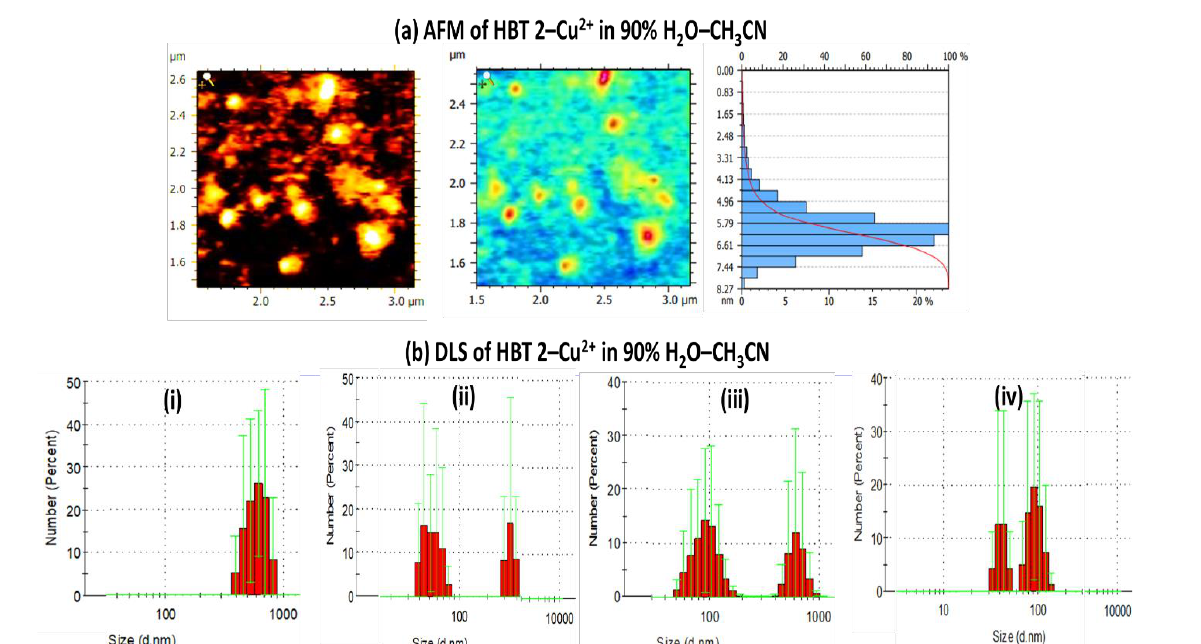
Figure 7. ( a ) AFM images, electron density profile, aggregate size-based bar graph of HBT 2 (1 µM), in the presence of Cu 2+ ions recorded in 9:1 (HEPES buffer:CH 3 CN) solution and ( b ) DLS analysis of ( i ) HBT 2 (0.5 μM) upon addition of ( ii ) 5, ( iii ) 10 and ( iv ) 20 equivalents Cu 2+ ions recorded in 9:1 (HEPES buffer: CH 3 CN) solution. Table 1. Determination of Cu 2+ ions in spiked real water samples taken from different areas of